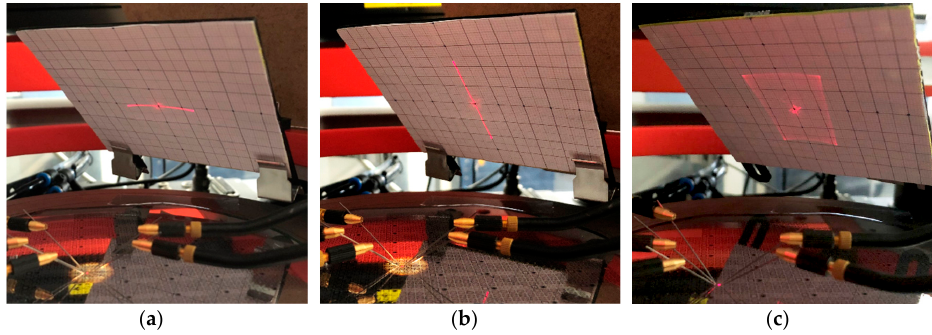
Figure 28. Scan pattern of Design 2 at 10 V: ( a ) x-axis; ( b ) y-axis; ( c ) Lissajous scan pattern.